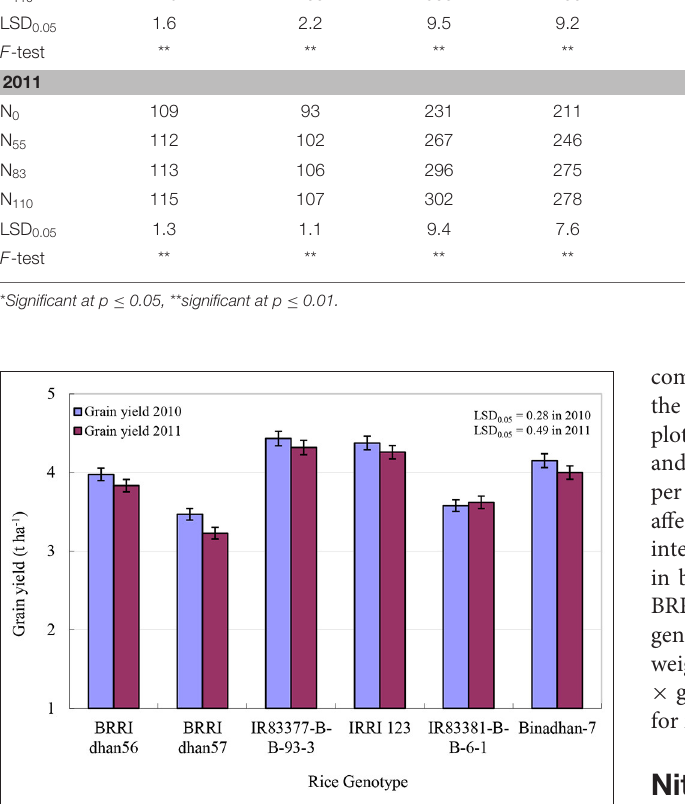
FIGURE 4 | Average grain yield of the rice genotypes in this study across all N treatments during 2010WS and 2011WS. Bars indicate the standard error of the